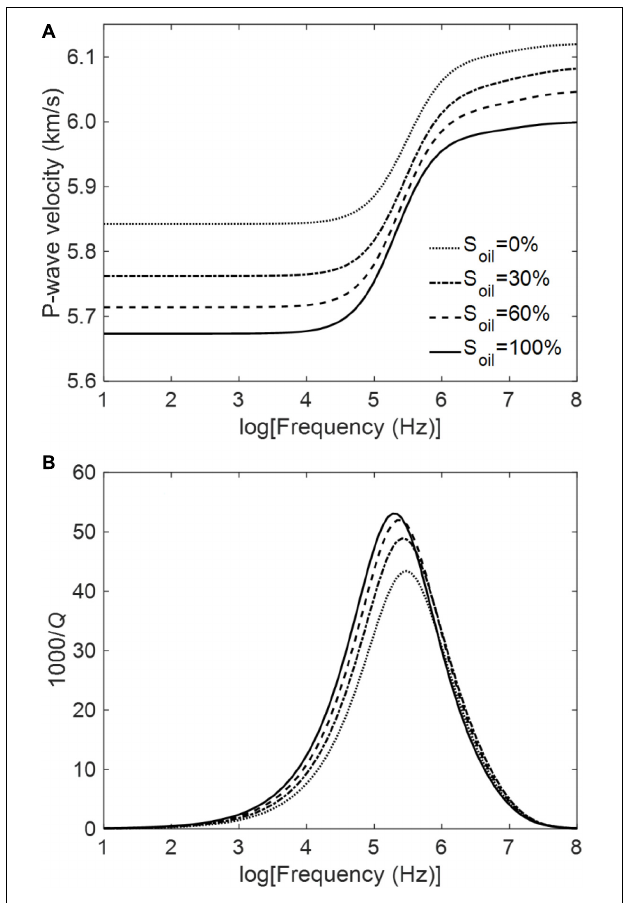
FIGURE 5 | P-wave velocity (A) and attenuation (B) as a function of frequency for varying oil